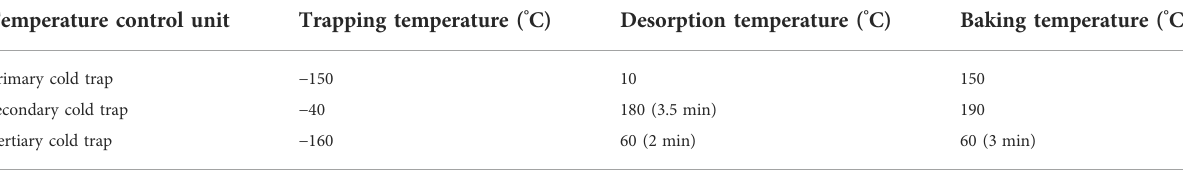
TABLE 1 Test conditions of the three-stage cold